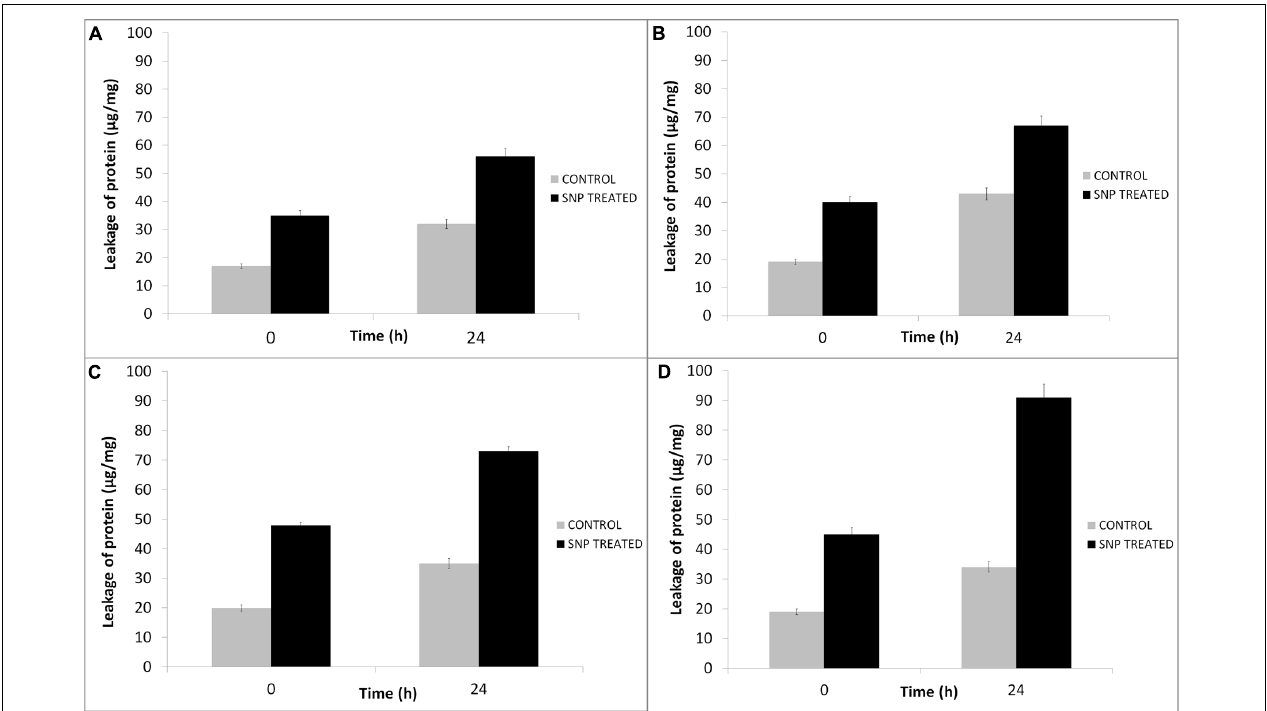
FIGURE 4 | Effect of SNPs on membrane leakage of proteins in haloarchaea (A) Haloarcula argentinensis, (B) Haloarcula tradensis, (C) Haloferax lucentense , and (D) Haloferax prahovense . Error bar represents standard